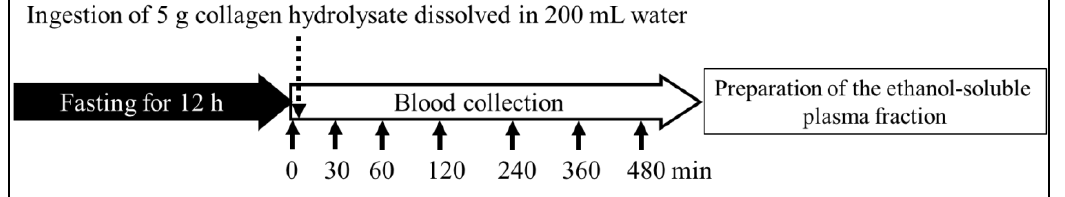
Figure 2. Design of the human study. Blood samples were collected before and after the ingestion of collagen hydrolysate.